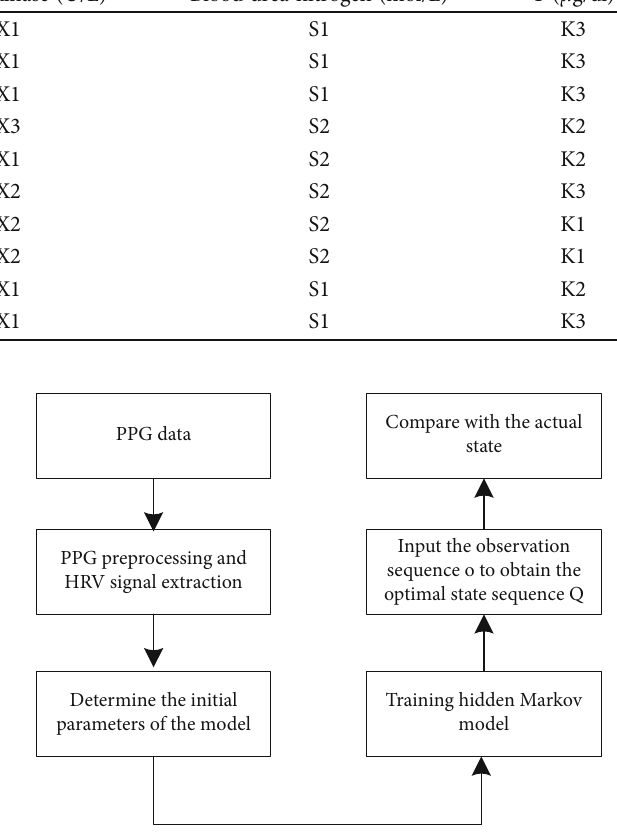
Figure 4: Establishment process of HMM sports training evaluation model based on big